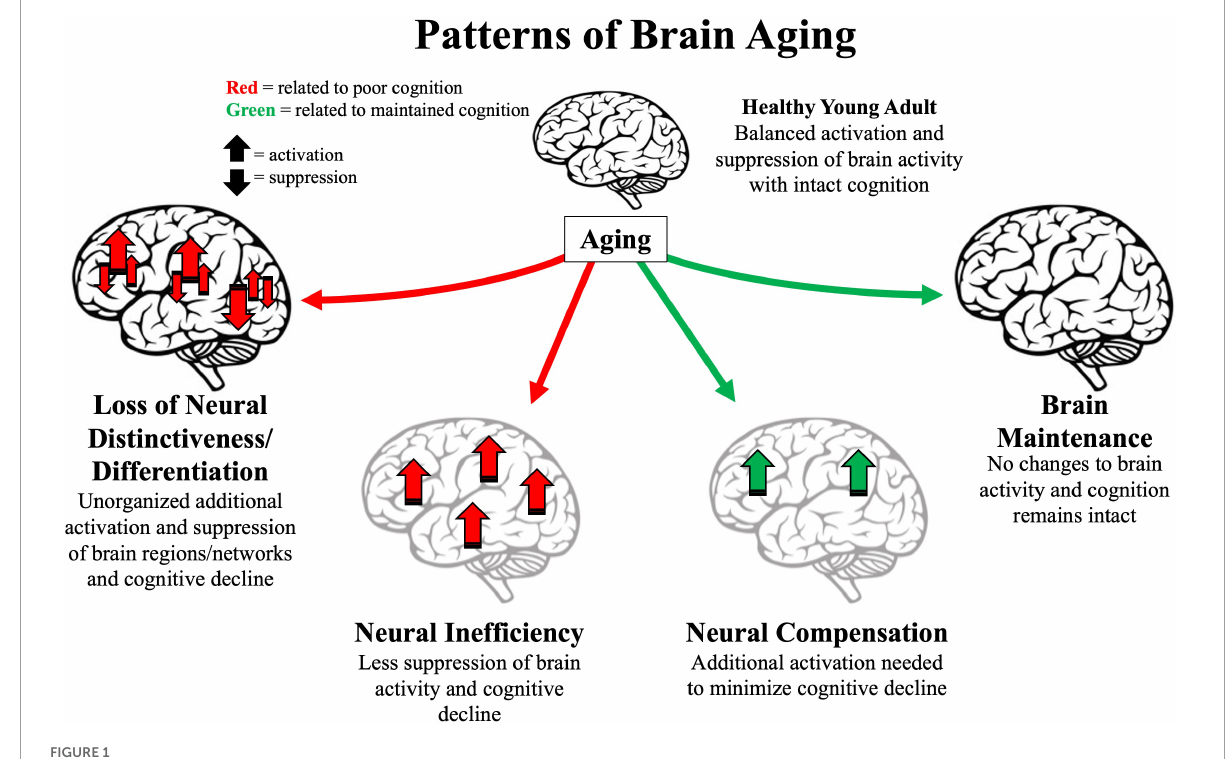
FIGURE1 Illustration of four major patterns associated with older age. Arrows represent activation or suppression of brain activity associated with maintained (green) or poor (red) cognitive performance. Light gray brains represent brain structure degradation. Location of arrows represent primary brain areas patterns implicated in brain patterns. Loss of neural distinctiveness/differentiation (left) is characterized by decreased difference of brain signals to different perceived categories or loss of modularity of specific brain networks. Neural inefficiency (lower left) is characterized by non-beneficial increases in brain activity. Neural compensation (lower right) is characterized by beneficial increases in frontoparietal regions. Brain maintenance (right) is characterized by some older adults’ brain structure and function as in young adulthood (top) .